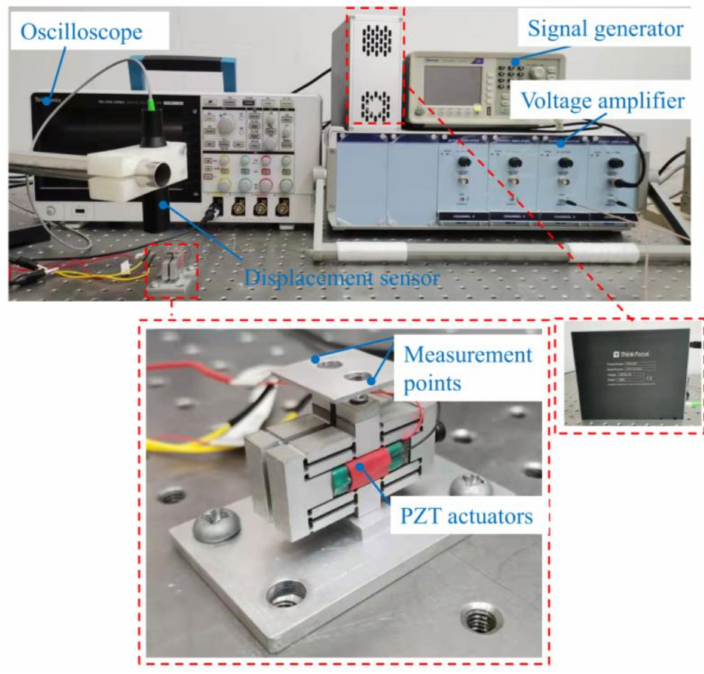
Figure 11. Experimental